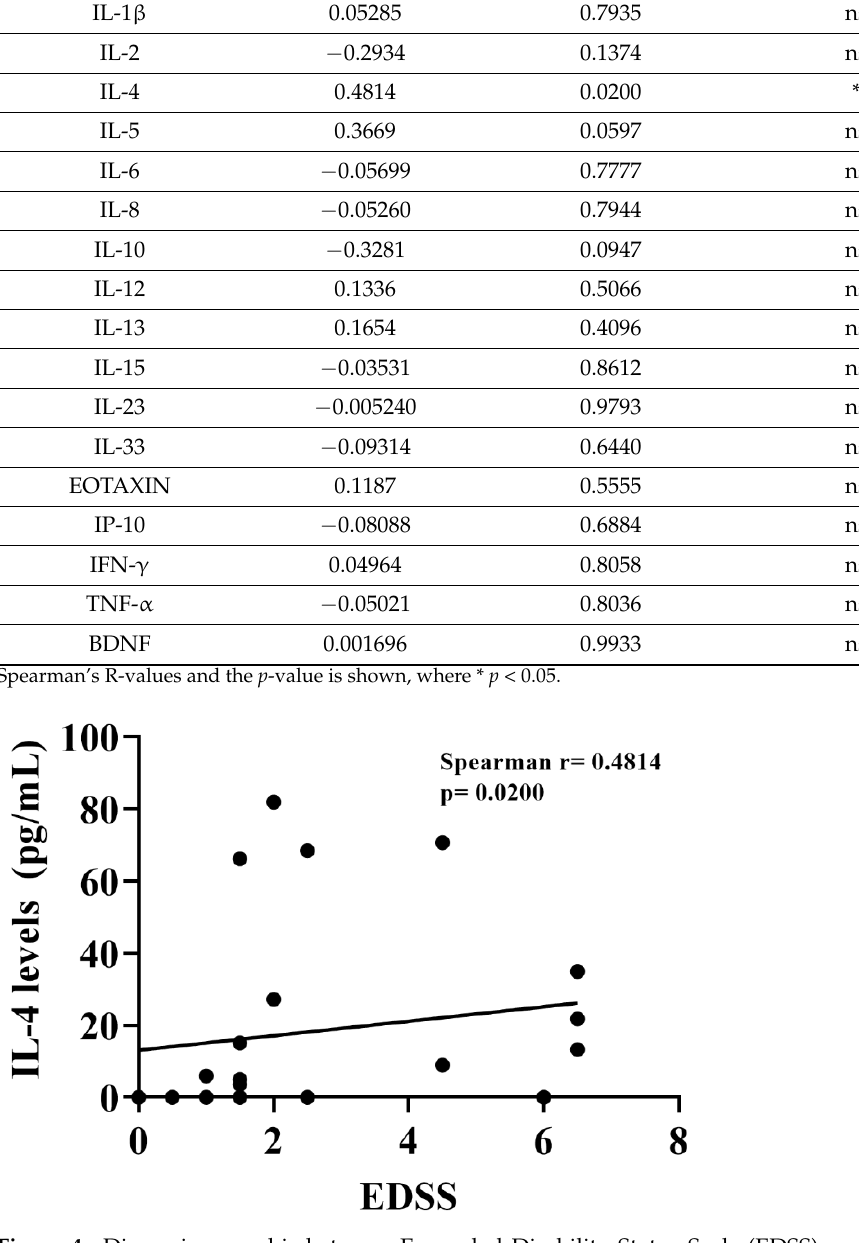
Figure 4. Dispersion graphic between Expanded Disability Status Scale (EDSS) and plasma interleukin 4 (IL-4) levels in patients with relapsing–remitting multiple sclerosis (Spearman’s rank correlation, r = 0.4814 with p = 0.0200).